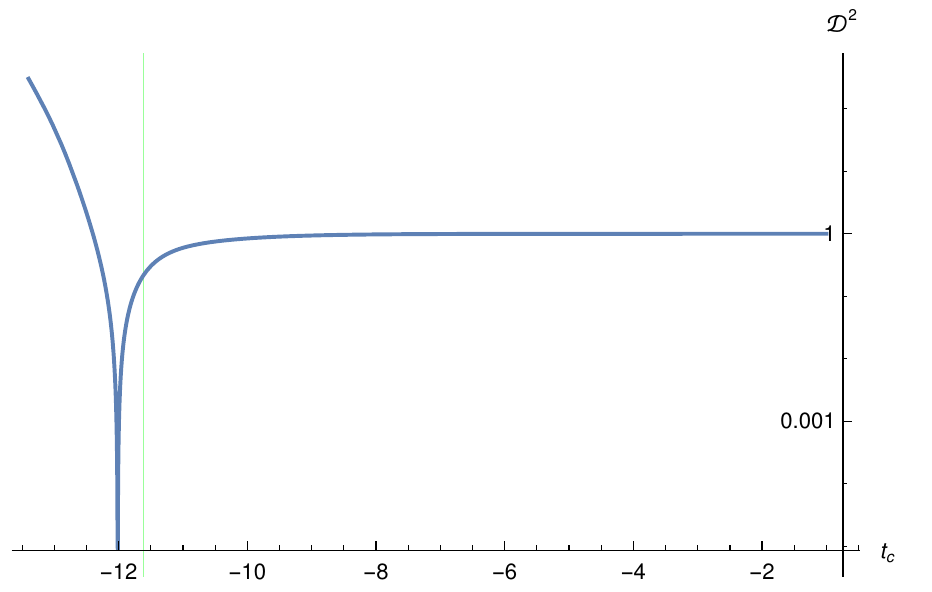
Figure 9. The function D 2 defined by Equation (103) for the case α 1 = 0, for which we have C bc = 1/ D . The vertical (green) line marks the position of the transition surface. When plotting this curve, we have chosen the relevant parameters exactly as those given in Figure 7.